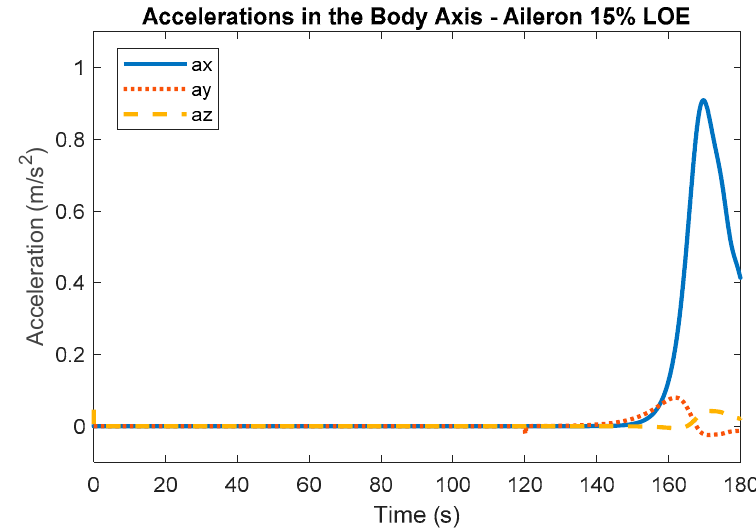
Figure 12. Accelerations in the body axis for the aileron 15% LOE fault.